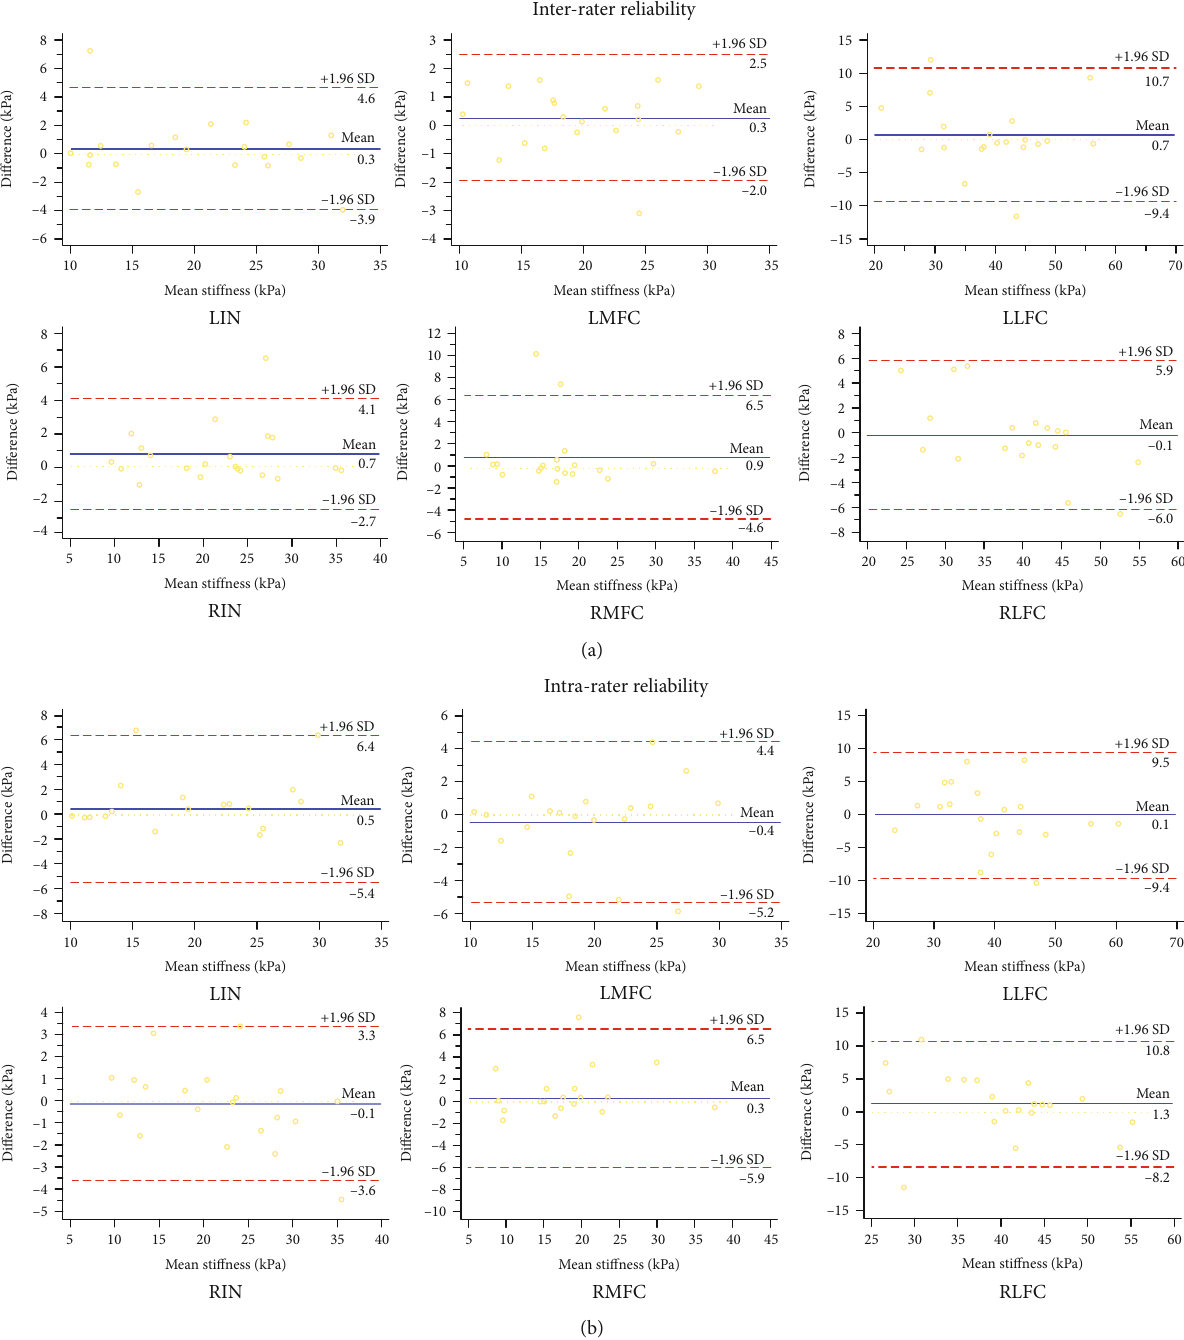
Figure 2: Bland and Altman plots of intra- and interrater reliability of distal FAC sti ff ness. The di ff erence of IN, MFC, and LFC in distal FAC sti ff ness between rater DWX and rater LM was plotted against the mean distal FAC sti ff ness (average of the 2 raters) for each participant (a). The di ff erence of IN, MFC, and LFC in distal FAC sti ff ness between day 1 and day 5 was plotted against mean distal FAC sti ff ness (average of the days for rater DWX) for each participant (b). In each panel, the continuous line represents the mean di ff erence, and the dotted lines represent 2 SD above and below the mean di ff